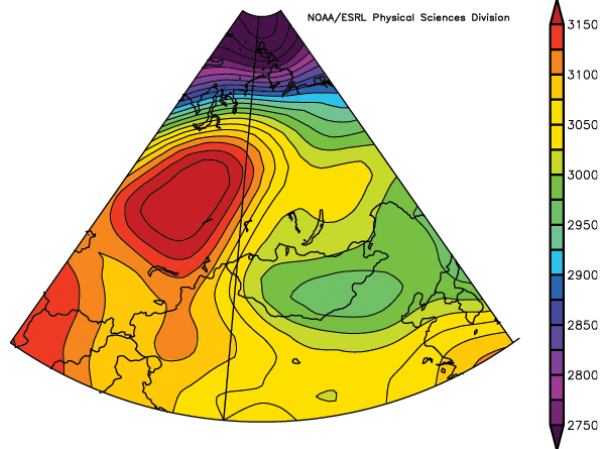
Fig. 17. Mean 700hPa geopotential height (m) pattern, 28 March 2008. Possible Takla Makan dust-raising event. Plot spans latitudes 40–85 ◦ N and longitudes 60–130 ◦ W. Mongolia is near the center of the plot, with Lake Baikal just north of Mongolia.